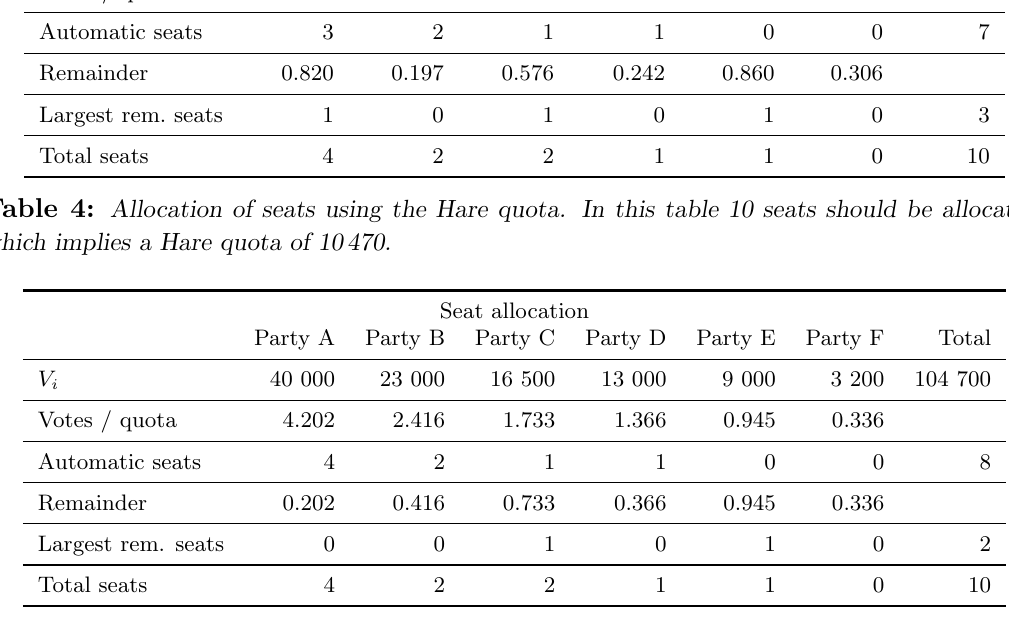
Table 5: Allocation of seats using the Droop quota. In this table 10 seats must be allocated, which implies a Droop quota of 9